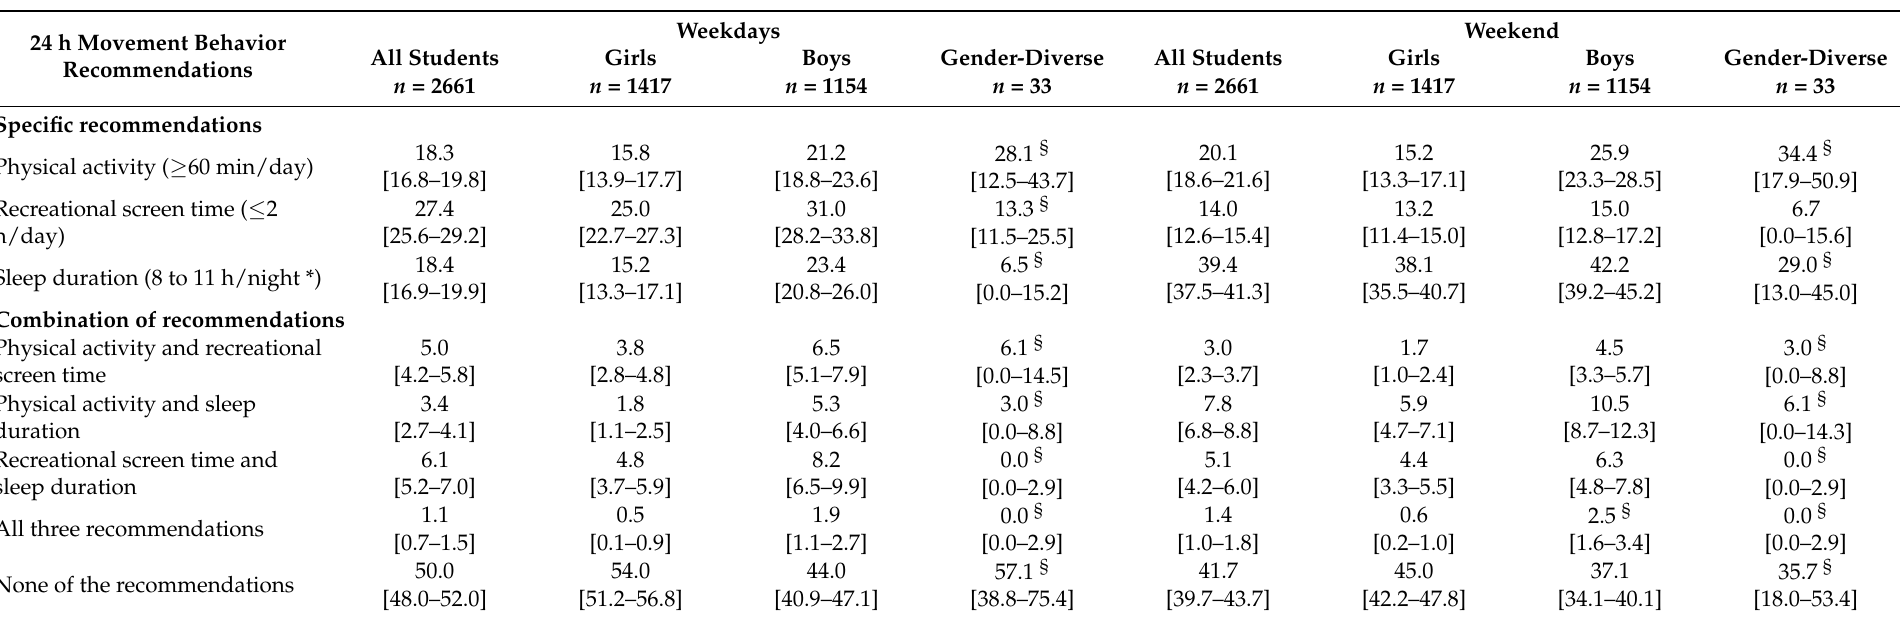
Table 1. Proportion of adolescents meeting the physical activity, recreational screen time, and sleep duration recommendations as of December